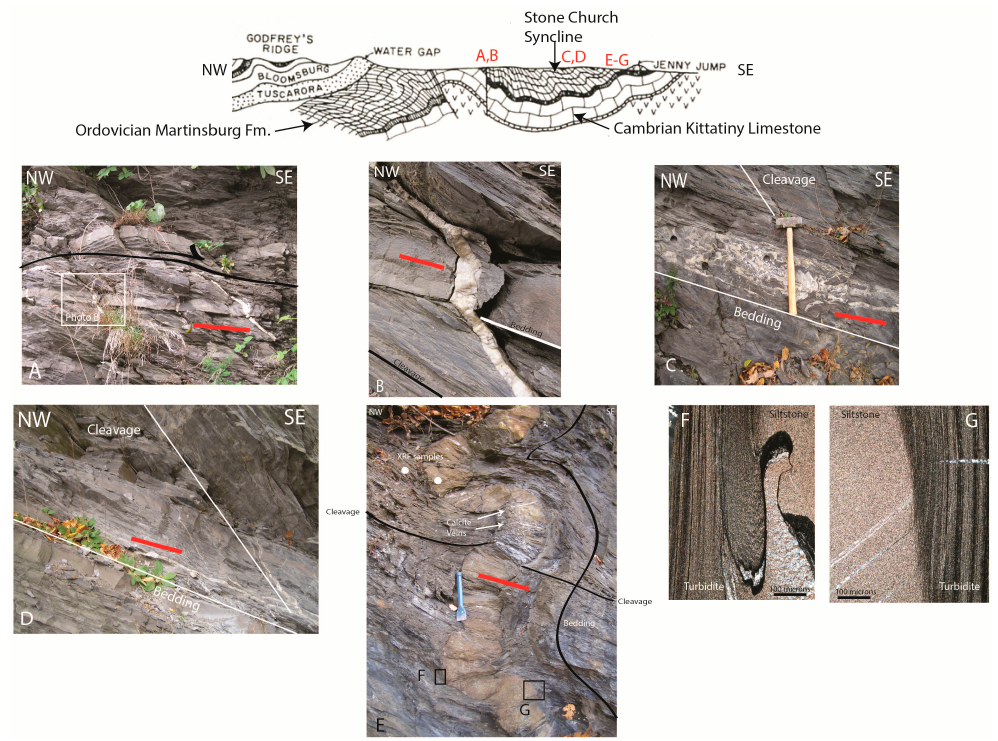
Figure 2. Photo collage of field photos along Maxwell’s [4] cross-section (see Figure 1). ( A and B ) SE-dipping, bedding-parallel normal fault on the northwest limb of the Stone Church syncline; ( C and D ) bedding and cleavage-parallel calcite fillings; ( D – G ) the folded, vertical calcareous siltstone layer with horizontal, bedding-normal calcite veins and the locations of the XRF samples (Table 3). The calcareous siltstone layer is part of the Martinsburg turbidite sequence and the cleavage is sheared along the sedimentological interface (F,G). Dark lines are stylolites and cleavage selvages. Red lines are the orientations of the ε 1 shortening axis for each site. Geosciences 2016 , 6 , 10